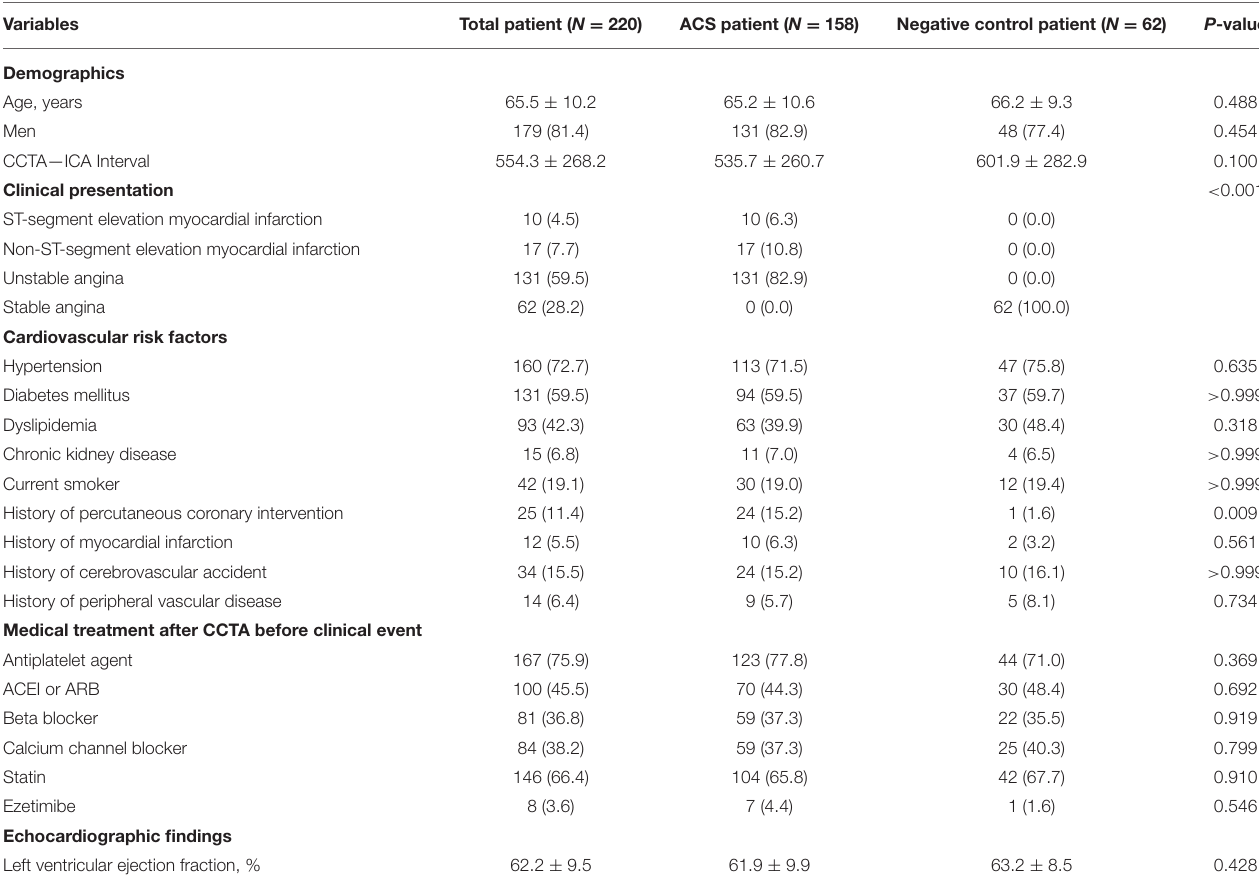
TABLE 1 | Baseline clinical